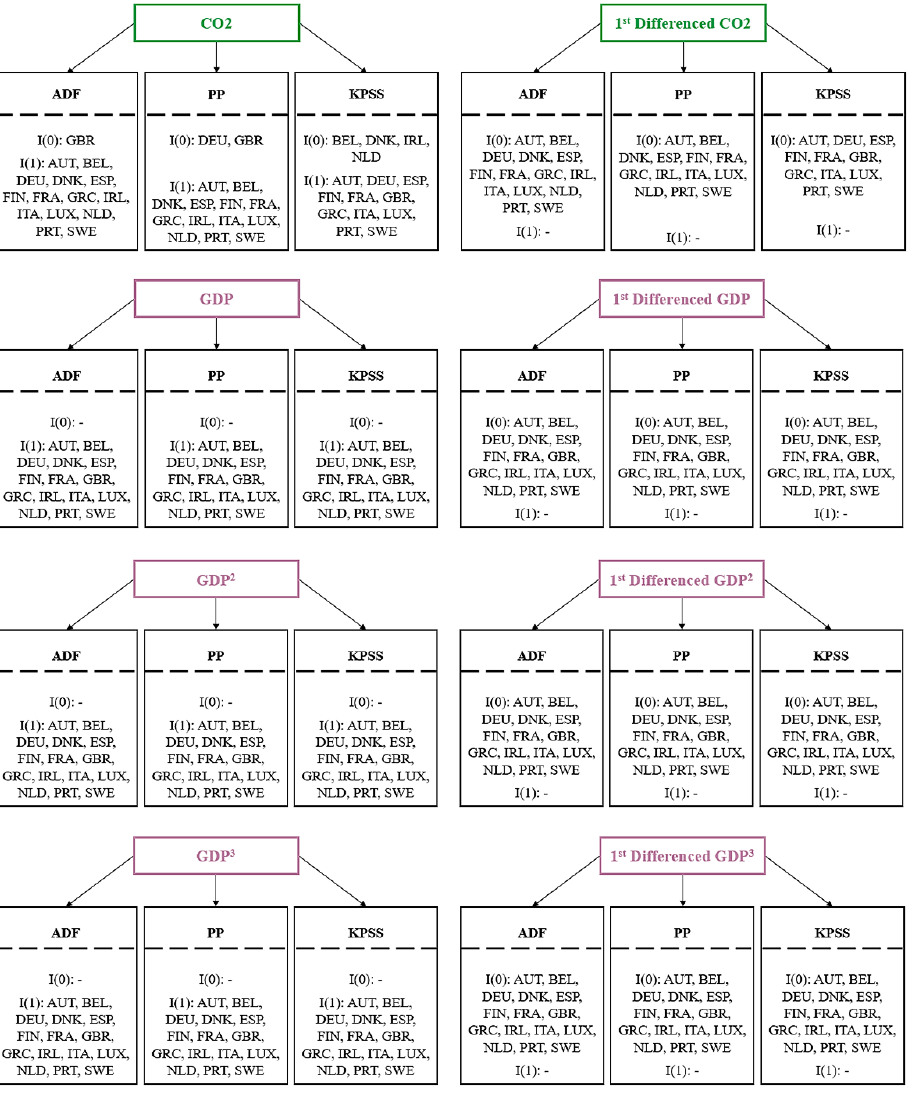
Figure 3. Unit root tests –